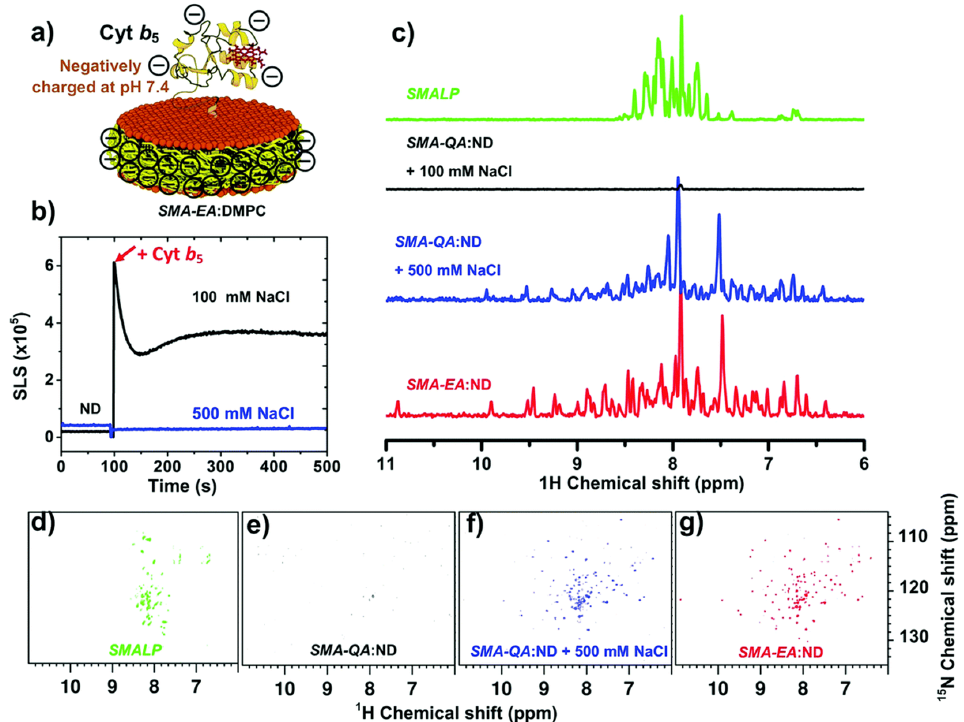
Figure 12. Reconstitution and structural characterization of cytochrome-b5 in various